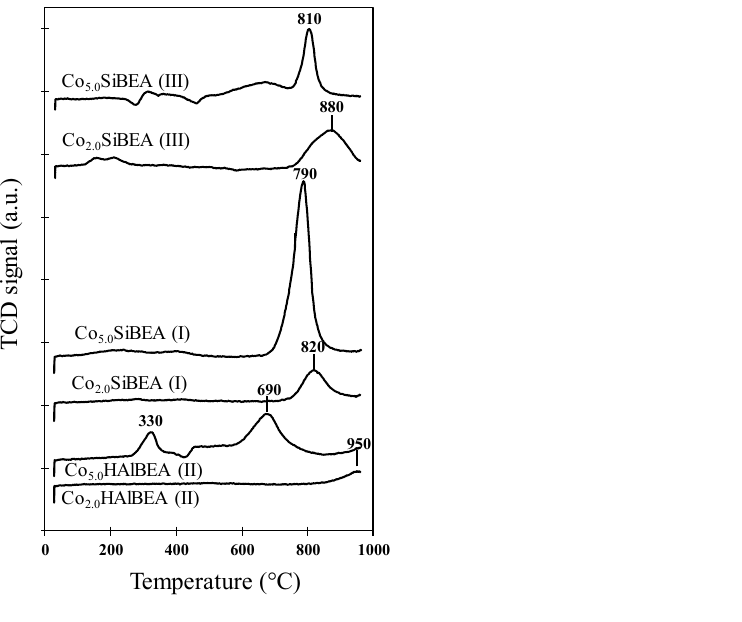
Figure 10. TPR-H 2 profiles of selected samples of Co x HAlBEA(II), Co x SiBEA(I), and Co x SiBEA(III) series.